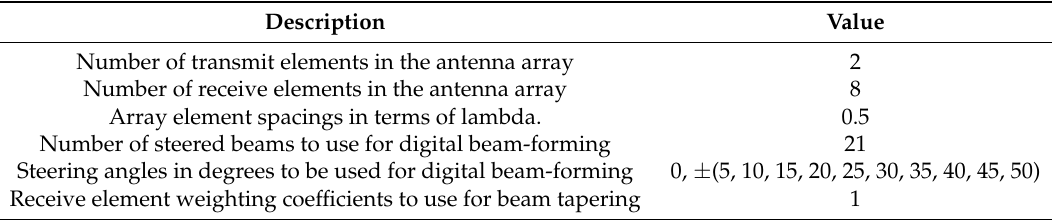
Table 5. Expert designed radar configuration.